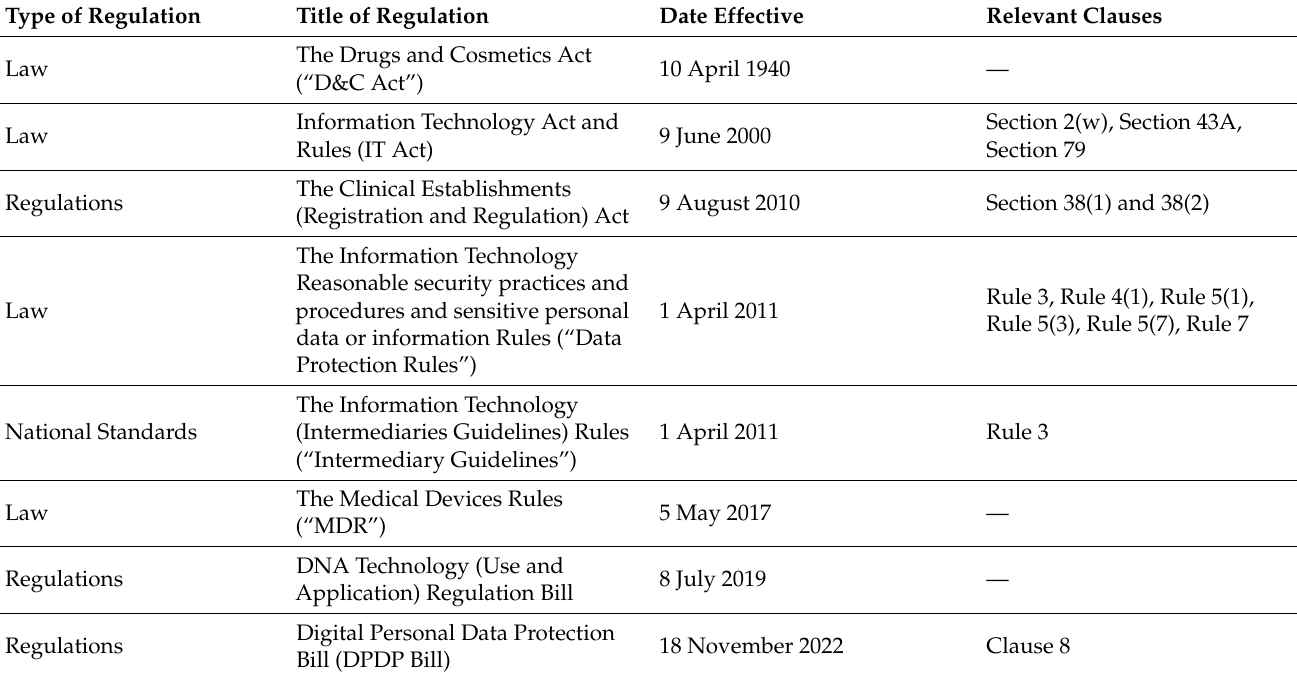
Table 1. Indian policies affecting the digitization of